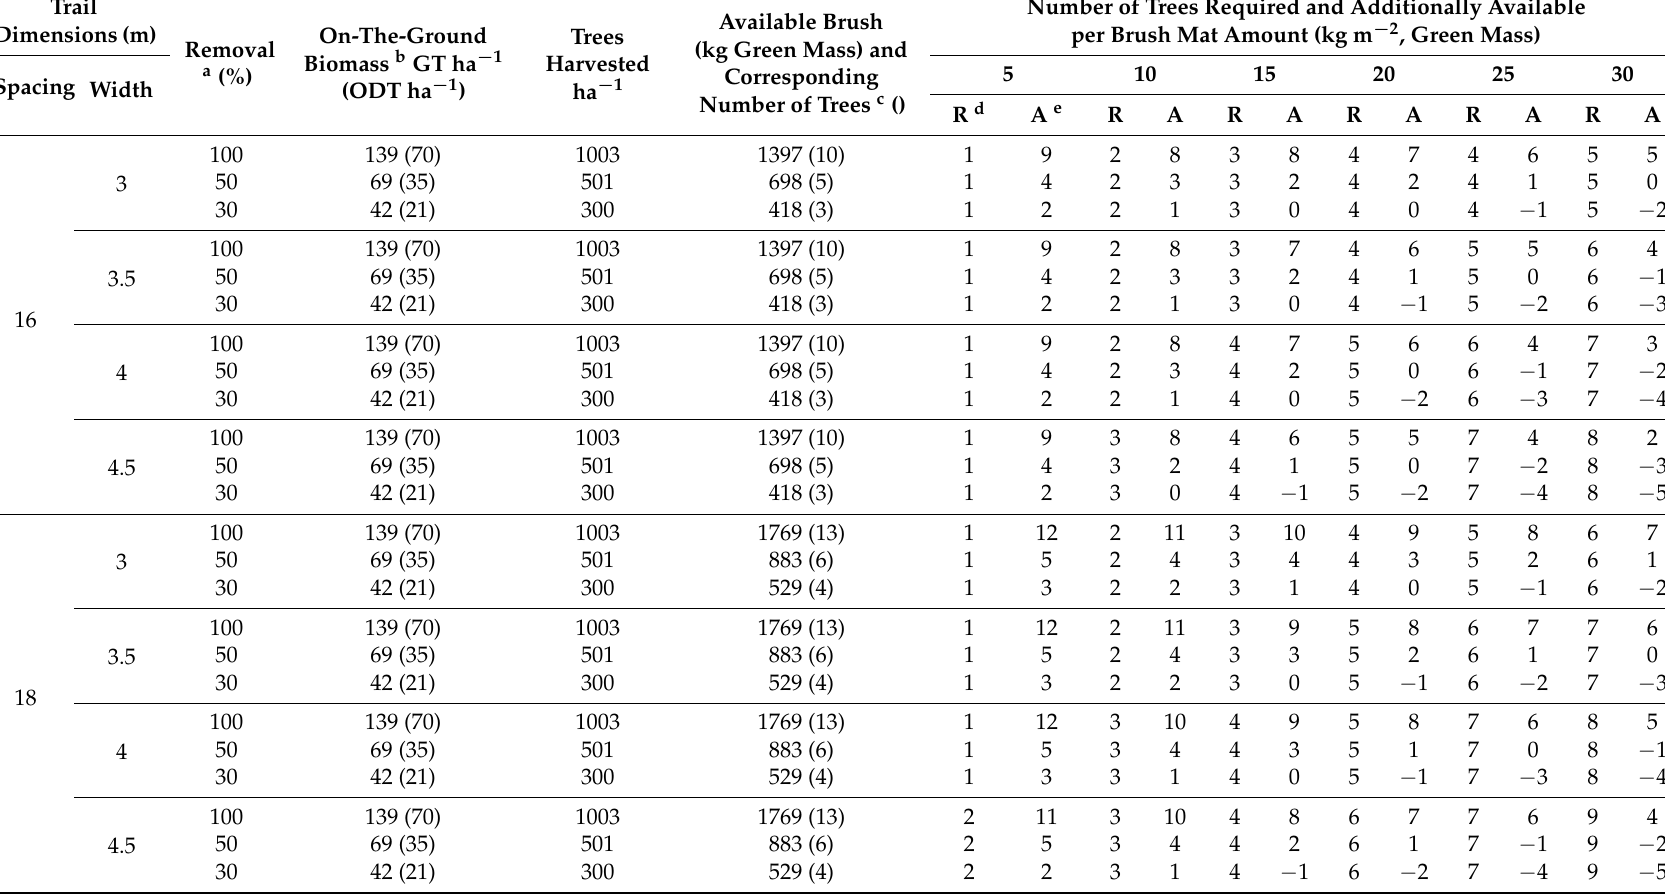
Table A6. Effect of varying brush mat requirements on the number of trees required to be delimbed on the machine operating trail and the number of trees additionally available for other uses (stand